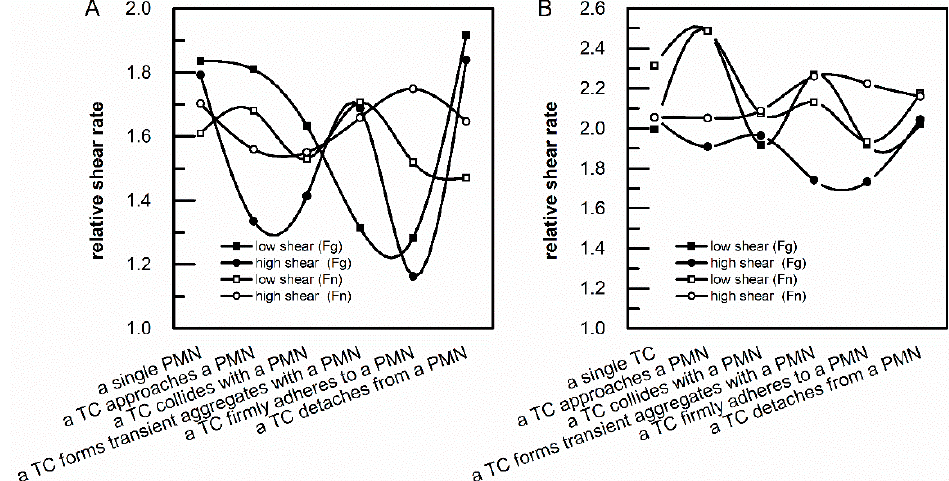
Figure 3. Relative shear rates above adherent cells in the presence of soluble fibrin (ogen). ( A ) Above an adherent PMN; ( B ) Above an adherent TC. Solid squares ( ■ ) represent a low shear condition (91.25 μ L min − 1 ) with sFg, solid circles ( ● ) represent a high shear condition (292 μ L min − 1 ) with sFg, open squares ( □ ) represent a low shear condition (91.25 μ L min − 1 ) with sFn, and open circles ( ○ ) represent a high shear condition (292 μ L min − 1 ) with sFn.